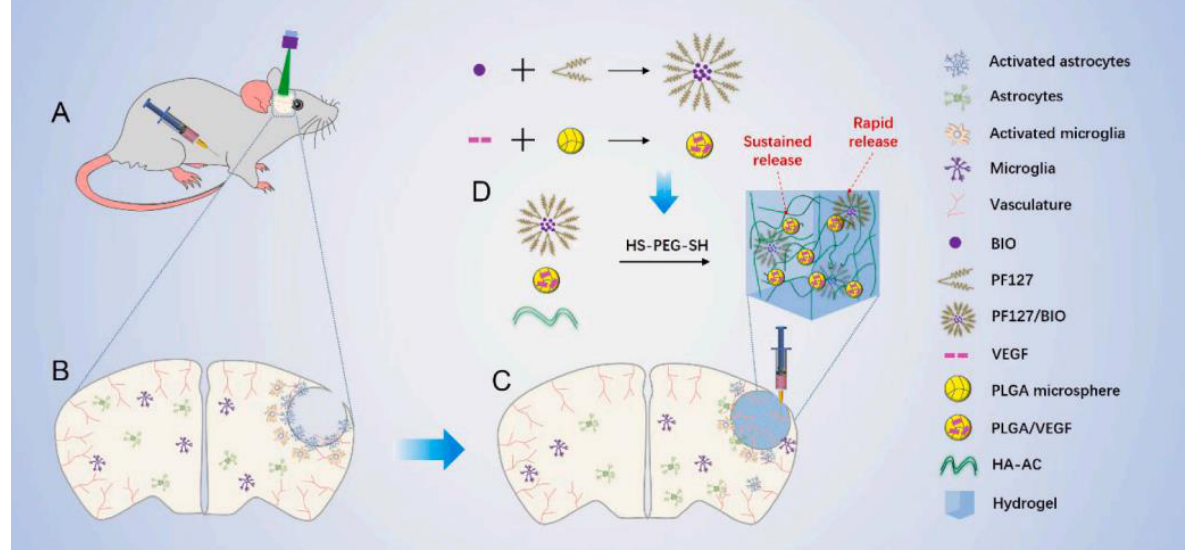
Figure 2. Schematic illustration of the applications of injectable hydrogels in the treatment of ischemic strokes in mice. ( A , B ) PT model in rats, in the PT model, blood flow disruption, microglia activation and astrocytes activation all occurred. ( C ) Injection of a dual-functional hydrogel into the infarct area ( D ) The preparation process of dual-functional hydrogel. Reproduced with permission from [56]. Copyright 2022, Elsevier.